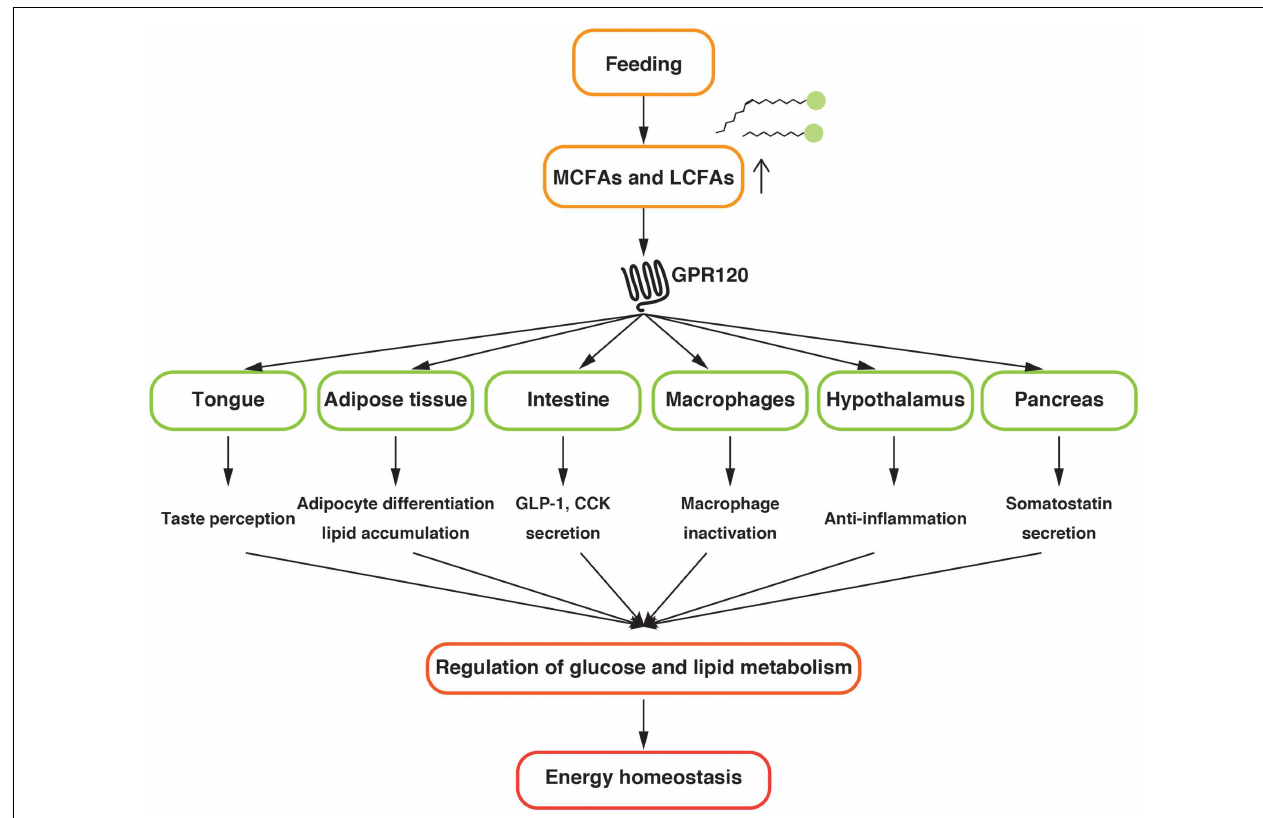
FIGURE 1 | Schematic diagram of the physiological function of GPR120 related to the energy homeostasis .